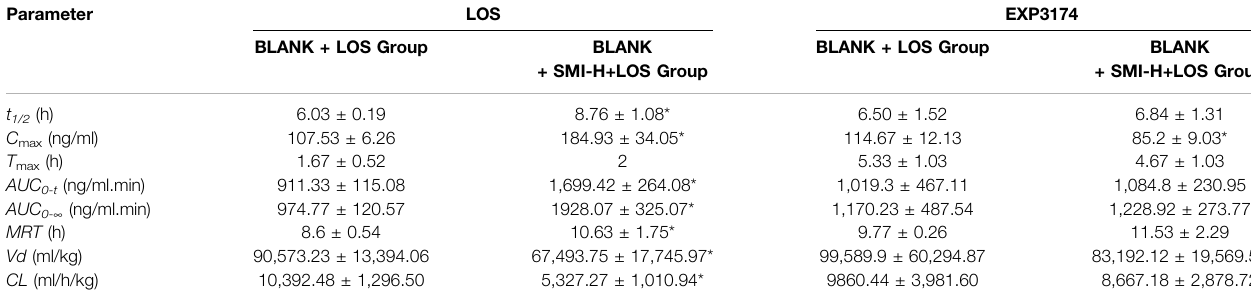
BLANK + SMI-H+LOS